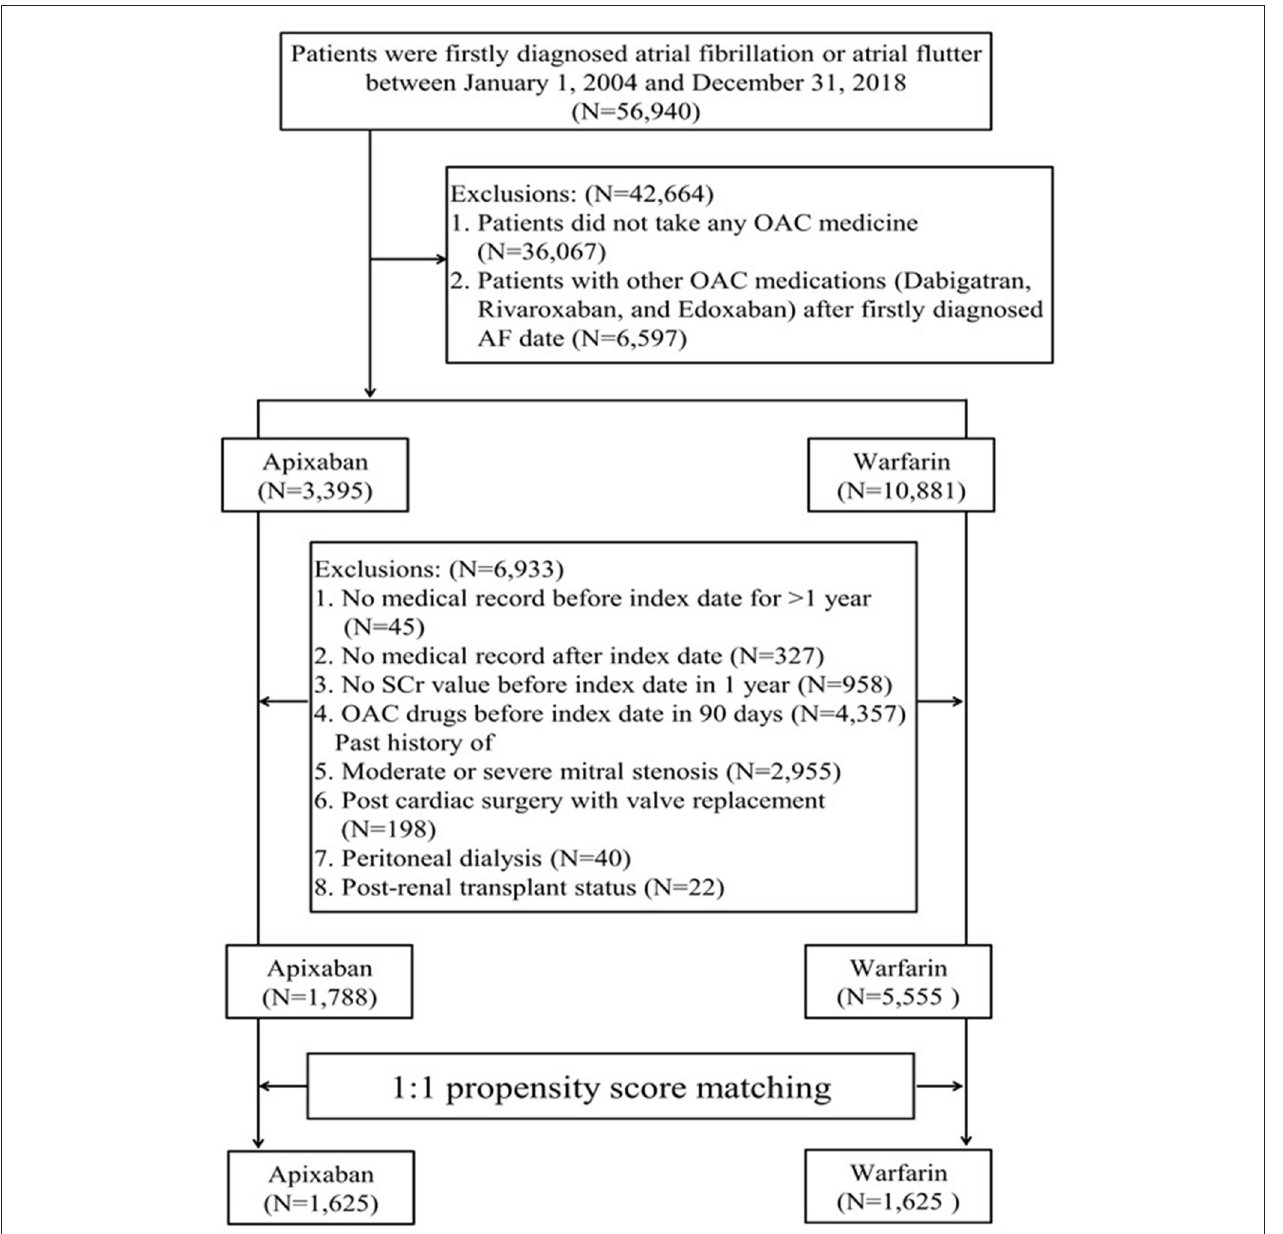
FIGURE 1 | Patient inclusion flowchart.